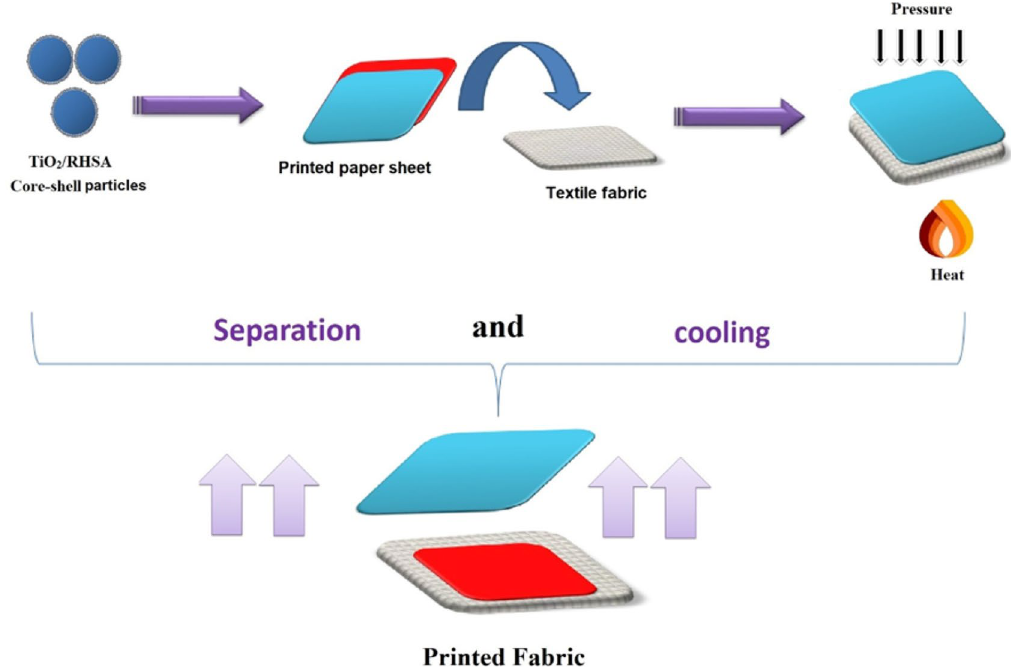
Figure 9. Graphical representation of heat transfer printing